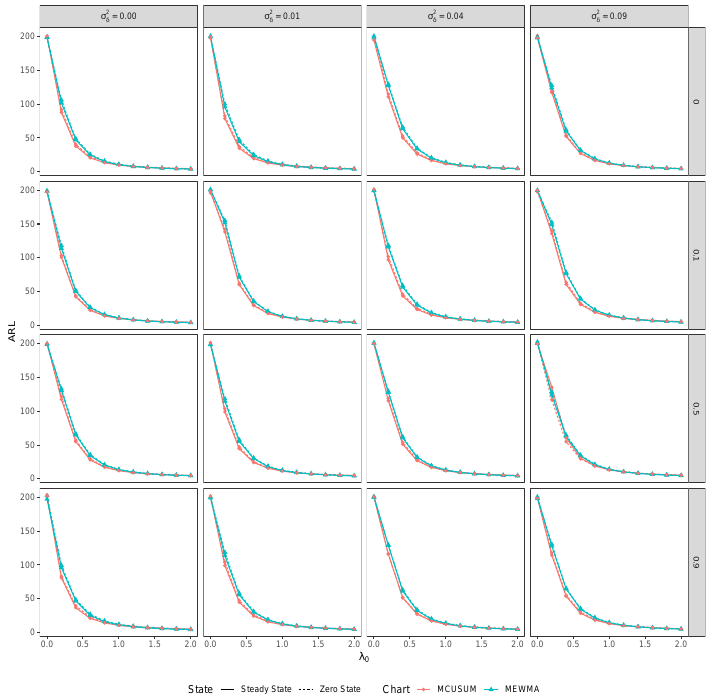
Figure 1. Zero-state and steady-state ARL for MCUSUM and MEWMA under shift in intercept.